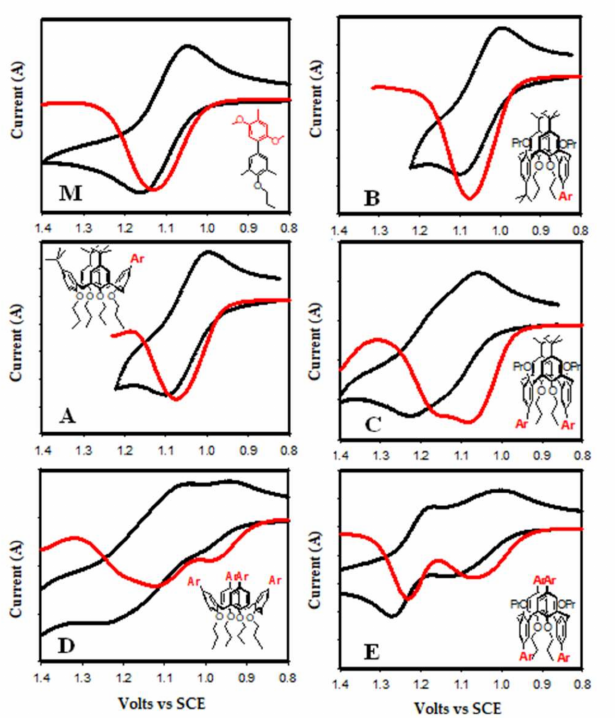
Figure 2. Cyclic and square wave voltammogram of the calixarene derivatives A – E and M . The mono-arylated calixarene donors A and B demonstrated a single reversible wave, whereas the diarylcalixarene C demonstrated two well-identifiable waves in their cyclic voltammograms (see Figure 2). Because of the presence of multiple aryl groups in tetraryl- calixarenes D , E , their cyclic voltammograms (CV) demonstrated overlapping (distorted) multiple reversible waves and are shown in Figure 2. Unfortunately, a quantitative